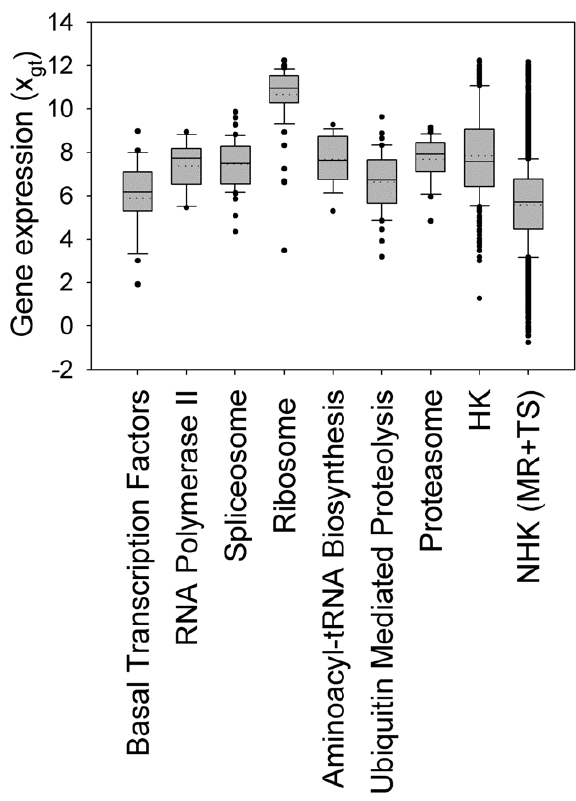
Figure 6. Range of expression levels of the HK genes in HK- enriched KEGG pathways. Shown are boxplots of the tissue-wide expression profiles of the HK genes in each of the 7 HK-enriched KEGG pathways. The results for the whole HK set (388 genes) and for the NHK set (12,687 genes) are presented on the right for comparison. Each box is bounded by the 25 th and 75 th percentile of the data, with the solid line within the box marking the median and the dotted line the mean, while the two short horizontal bars indicate the 90 th and 10 th percentile of the data and dots beyond these two bars are outliers. Gene expression levels were log2 transformed and are denoted by x gt